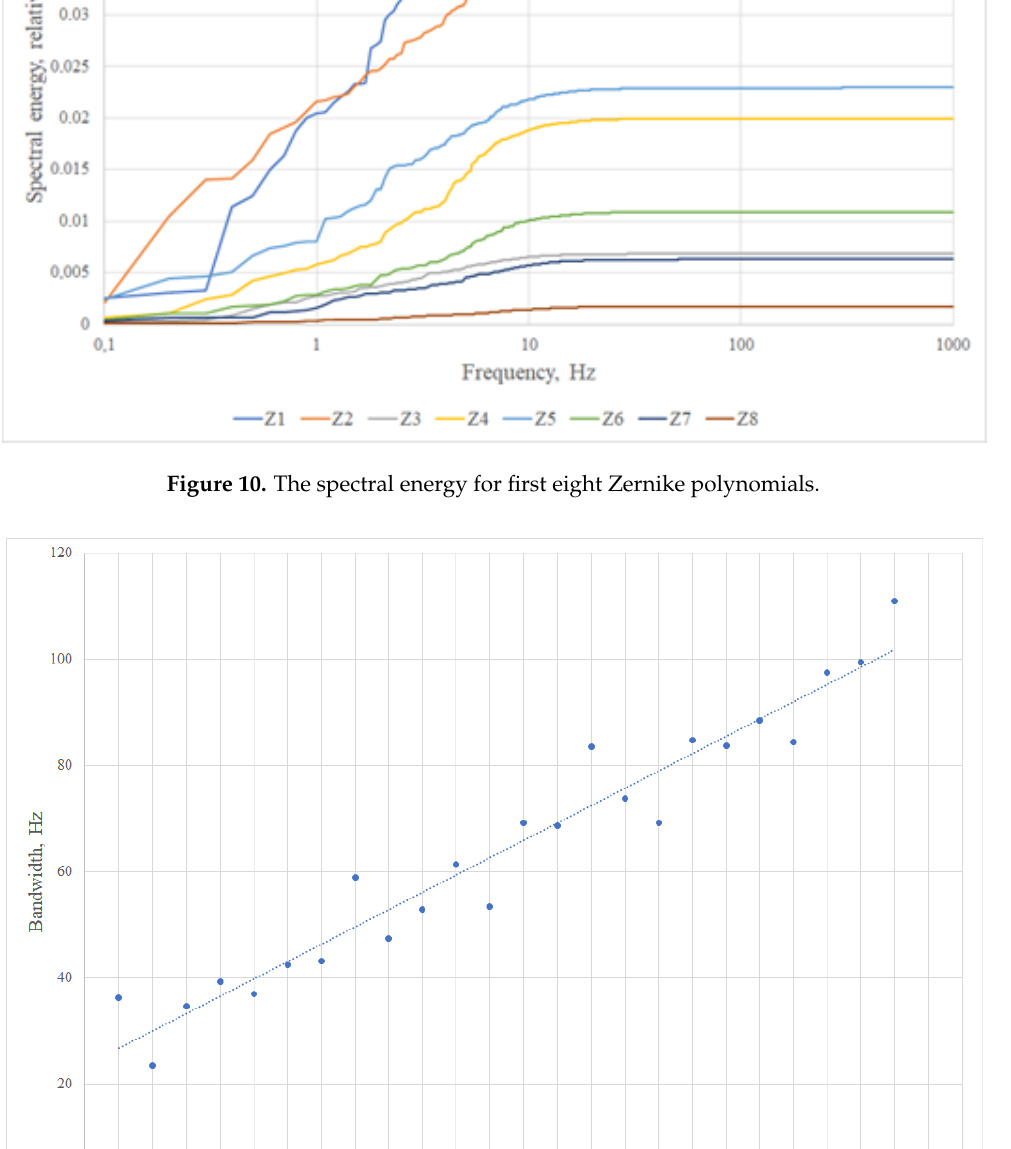
Figure 12. The spectral energy of wavefront aberrations before correction. The residual aberrations are quite small, so Figure 13 represents a diagram of the uncompensated aberrations, expressed as a percentage of the entry level.